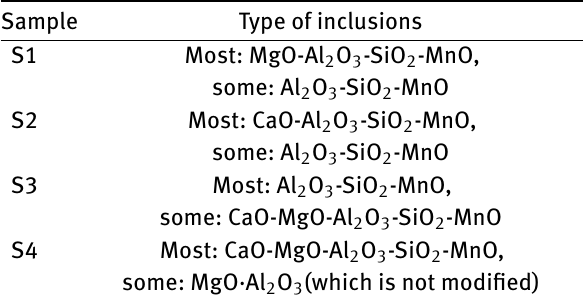
Table 4: Inclusions types in steel of different acid slags